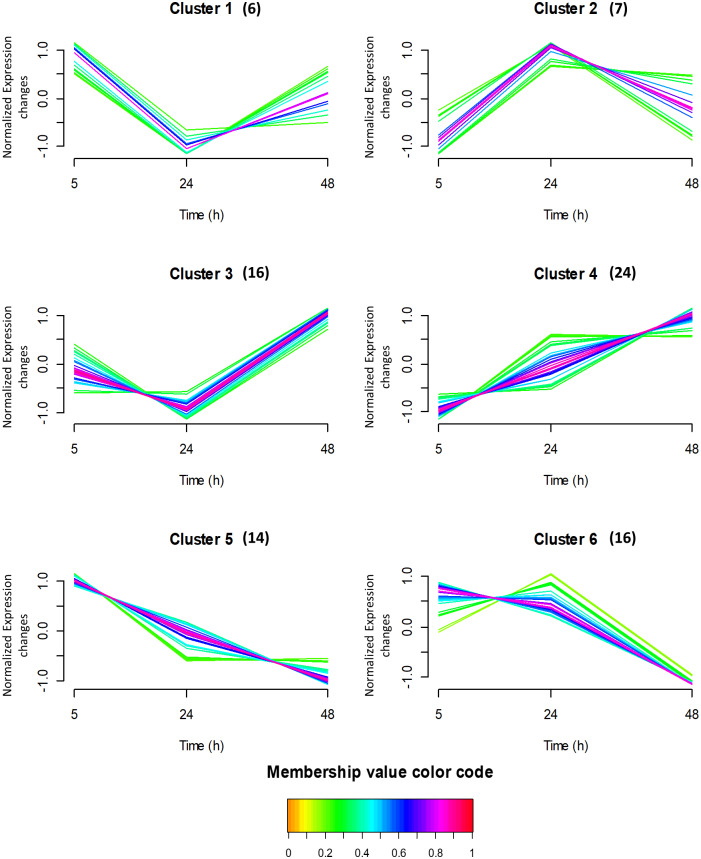
Time-course protein profiles obtained by fuzzy c-means clustering in HK-2 cells treated with HG (25 mM glucose)-hypoxia (1% O2) in comparison to NG (5.5 mM glucose)-normoxia (21% O2) at 5, 24 and 48 h.The y axis is log10 transformed and normalized, and the number of proteins considered in each cluster is given in parentheses. Each trace is colour coded according to its membership value for the respective cluster (see colour bar).